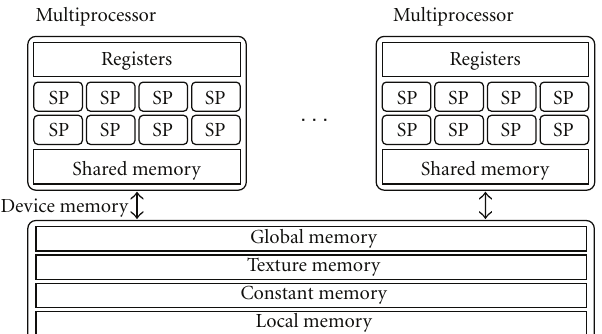
Figure 5: General structure of a CUDA-enabled GPU, showing the device memory, the multiprocessors, the scalar processors (SP), and the relevant memory